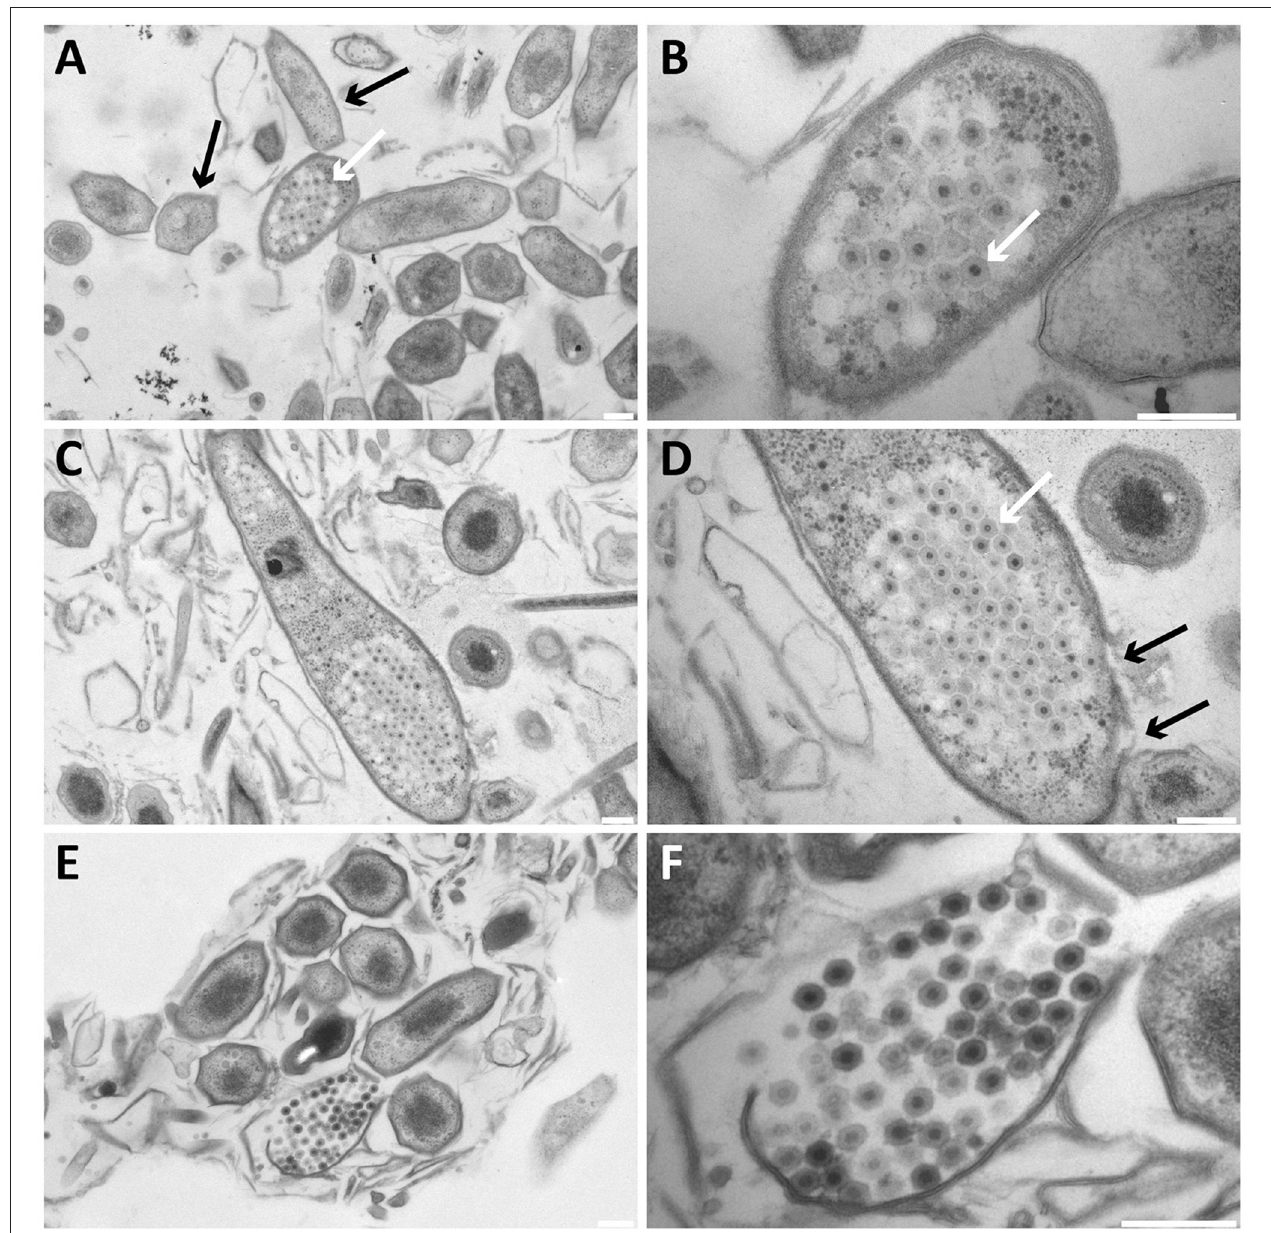
FIGURE 2 | Transmission electron micrographs of high-pressure frozen, freeze-substituted, resin-embedded, and thin-sectioned Methylomirabilis cells taken from a bioreactor enrichment culture. (A,B) Infected Methylomirabilis cells (white arrow in A ) are in clusters among non-infected cells (black arrows in A ). The bacteriophage (white arrow in B ) has a hexagonal shape and an internal electron dense core. (C,D) The bacteriophages are organized in a highly packed formation (white arrow in D ). The replication and assembly of bacteriophages causes the Methylomirabilis cell to swell and eventually the cell wall breaks (black arrows in D ). (E,F) Lysed Methylomirabilis cell releasing the viral progeny. (B,D,F) are enlargements of (A,C,E) , respectively. Scale bars; 200